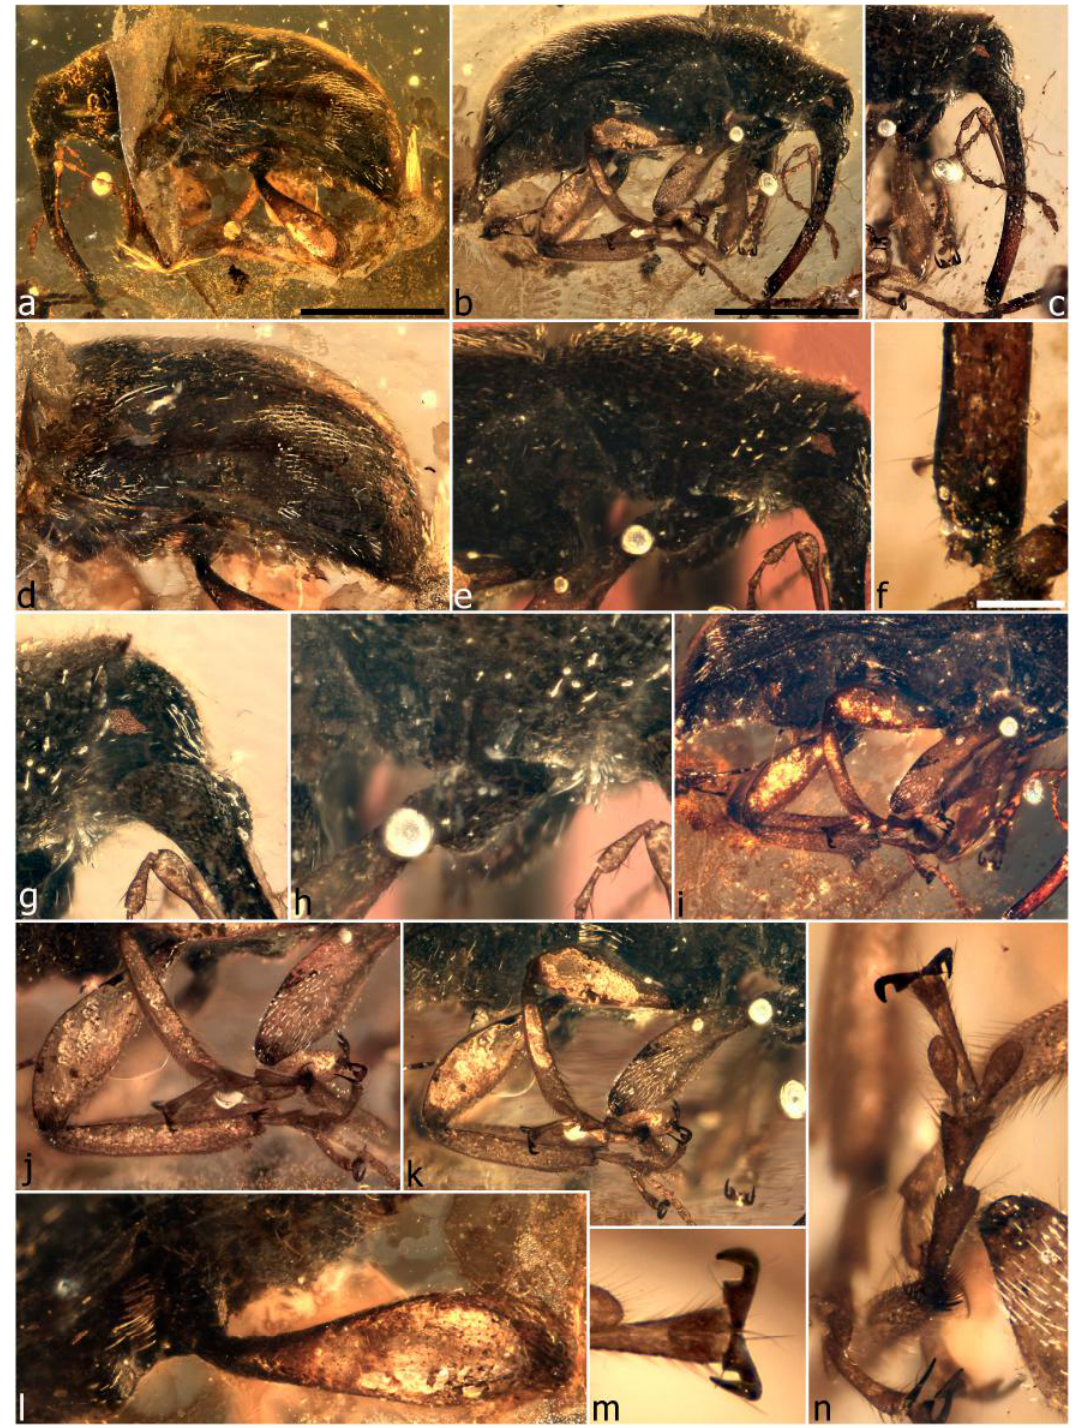
Figure 68. Myanmarus caviventris sp. n., holotype. Habitus, left lateral ( a ); habitus, right lateral ( b ); head and antennae, right lateral ( c ); elytra, left lateral ( d ); head and prothorax, right lateral ( e ); apex of rostrum and right mandible, dorsal ( f ); head, right lateral ( g ); prothorax showing notosternal suture, right lateral ( h ); abdomen showing ventrites, and legs, right lateral ( i ); legs, right lateral ( j ); same ( k ); left metacoxa and -femur, showing dense line of lighter setae on posterior metaventral margin ( l ); tarsal claw, ventral ( m ); protarsus, ventral ( n ). Scale bars: 1.0 mm (a,b); 0.1 mm (f).